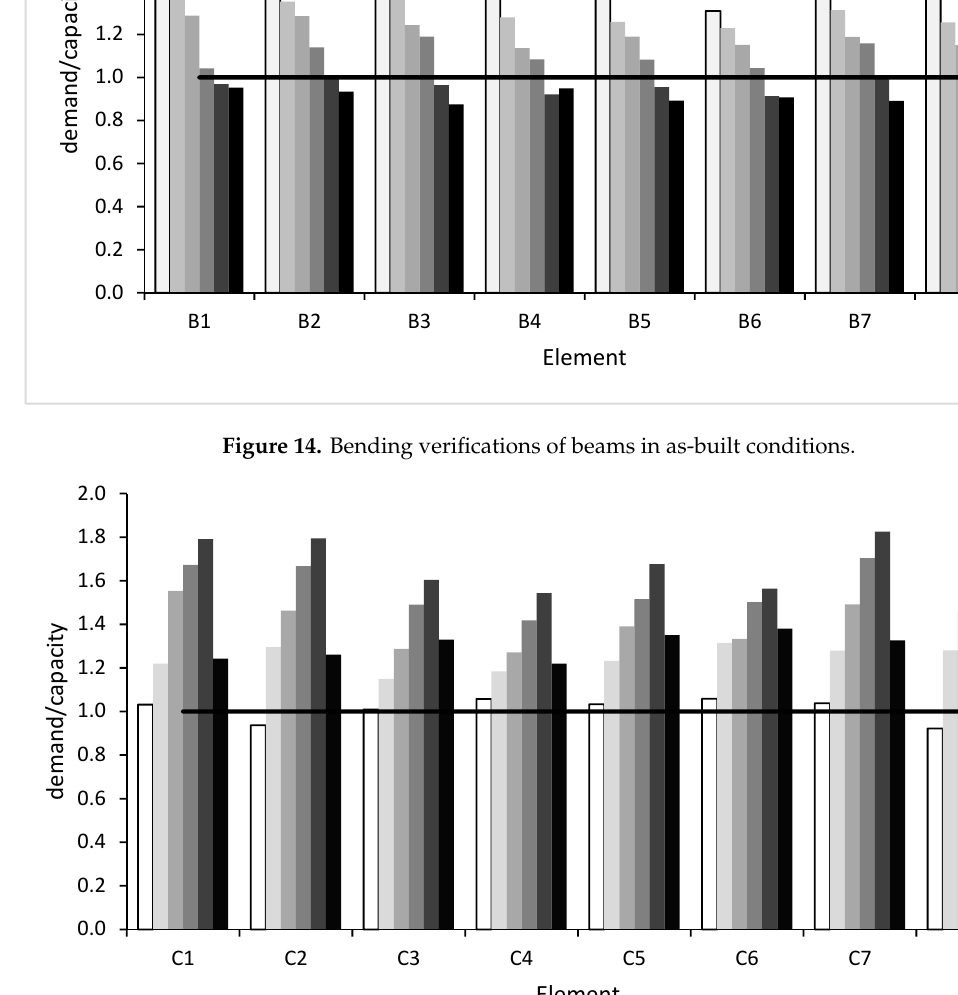
Figure 17. Shear verifications of columns in as-built conditions. From Figure 14 it can be observed that all beams from the first to the fourth story are not verified for ductile mechanism and, in the worst case, the acting bending moment is more than 1.6 times the bending capacity. All beams of the fifth and sixth floors satisfy the ductile mechanism verification. In Figure 15, ductile verifications for columns of the lateral block are reported. It can be seen that the only elements that satisfy these verifications are columns C2 and C8 at the base, which have the sections with the greatest amount of reinforcing bars. For each column it is possible to observe that the ratio between demand and capacity increases with the height, because the resisting moment of the columns decreases. From Figure 16, it is possible to observe that all beams of the lateral block satisfy shear verifications. From Figure 17 it can be observed that none of the first-level columns satisfy the shear verification and, in the worst case, the acting shear is 1.52 times greater than the shear strength. This is due to the presence of a small amount of transverse reinforcement in the columns and a great shear force at the building base. On the second level only two columns are verified, and the more eccentric second-level columns, with respect to the center of mass of the plan (C1 and C7), exhibit the maximum value of the acting shear/shear strength ratio. At this level most columns do not satisfy the verification, because there is a reduction in the section from the ground floor to the first floor and a consequent strength reduction. On the upper levels, the columns are mostly verified. In conclusion, the seismic analysis carried out on this case study shows that a lot of bearing elements do not satisfy the verifications required by the Italian Building Code [14] for existing buildings. This is due to the characteristics of structural members and also to the marked torsional behavior of the structure.